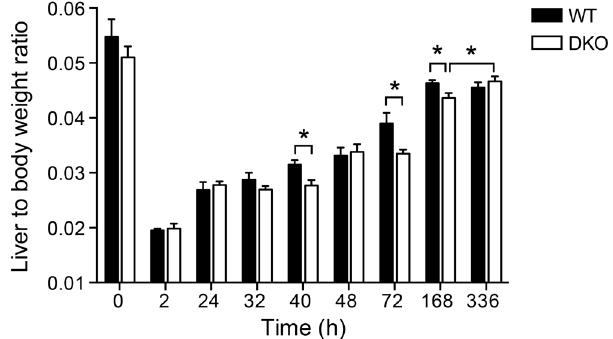
Figure 1. Lack of cytosolic nucleic acid sensing pathways impairs recovery of liver tissue after partial hepatectomy. Liver-to-body weight ratios were determined at the indicated time points following partial hepatectomy (n = 5 to 7 mice per time point in each group). * P < 0.05 (two-tailed unpaired Student’s t-test or the Mann-Whitney U